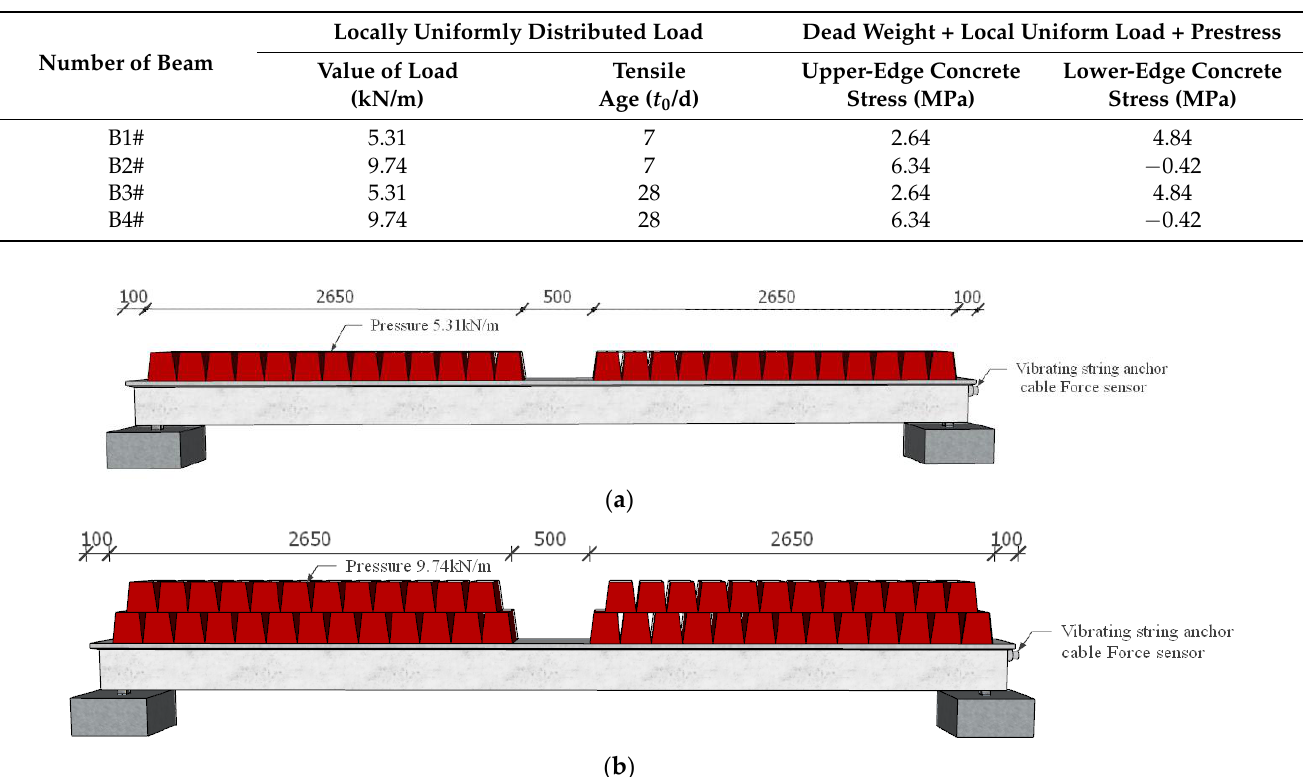
Figure 3. Natural maintenance of T-beam field test station. Table 1. Mechanical property parameters of the secondary loading of the T-beam.